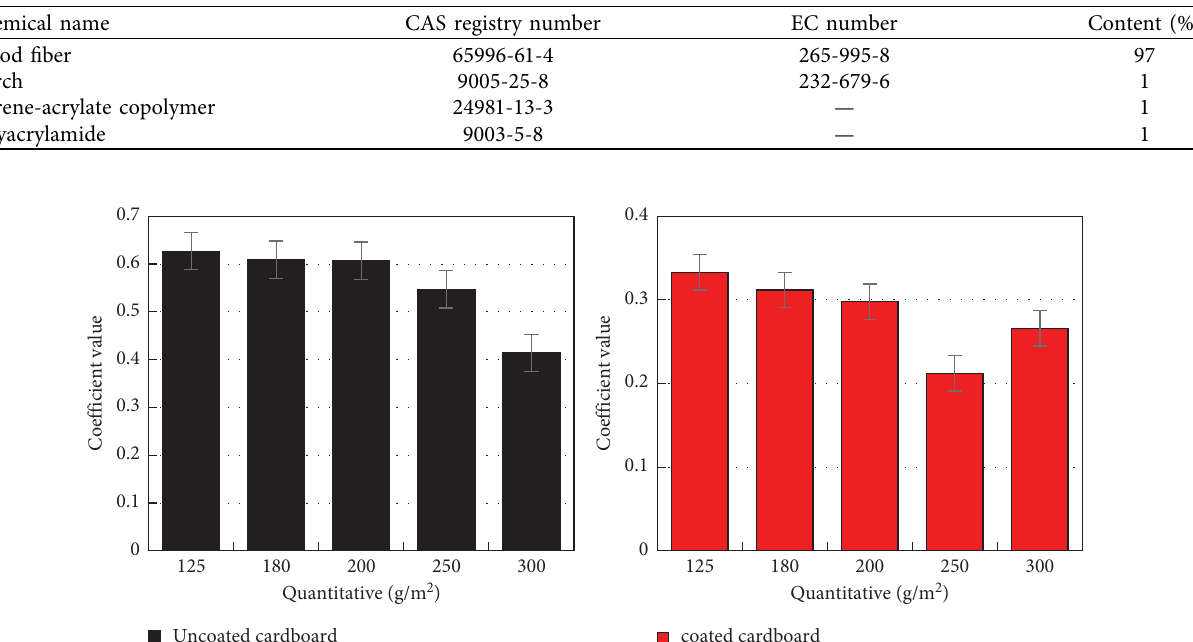
Figure 5: Values of friction coefficient of uncoated and coated cardboard in different quantitative paperboards.